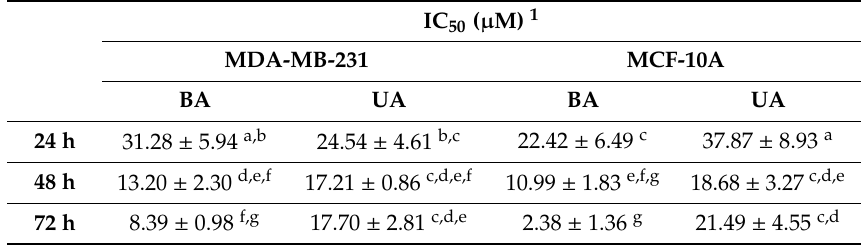
Table 1. IC 50 values regarding cell viability inhibition by betulinic acid (BA) and ursolic acid (UA) on the MDA-MB-231 and MCF-10A cell lines, as determined through the MTT assay.